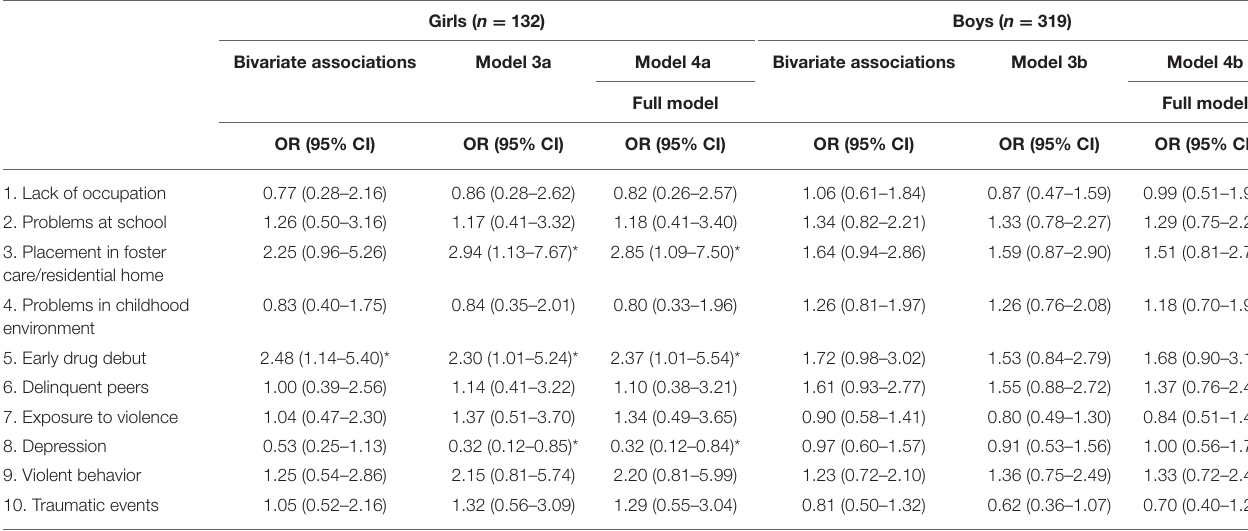
TABLE 3 | Bivariate associations between risk factors and indication of SUP 3 years after initiation of